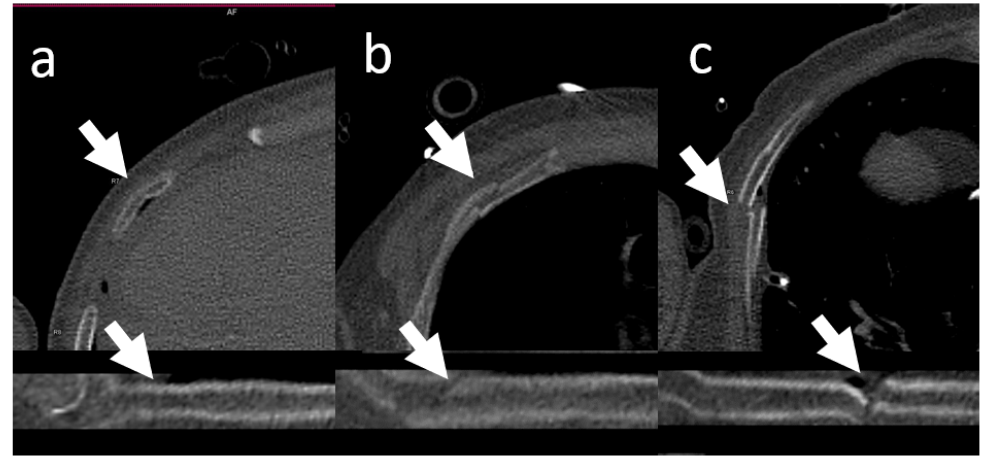
Figure 5. Fracture patterns. Fractures were classified by the study coordinator as incomplete/buck- led ( a ), undislocated ( c ), or dislocated ( b ).